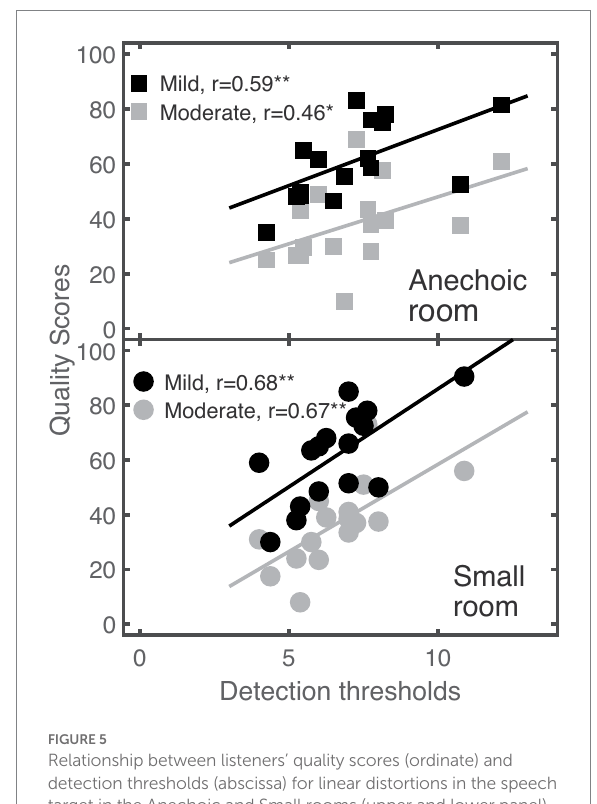
FIGURE 5 Relationship between listeners’ quality scores (ordinate) and detection thresholds (abscissa) for linear distortions in the speech target in the Anechoic and Small rooms (upper and lower panel). Mild and moderate distortions are represented by black and gray symbols, respectively. Linear regression models fitted to data are shown as solid lines. Statistically significant effects based on levels of 0.05, and 0.01 are indicated as * and